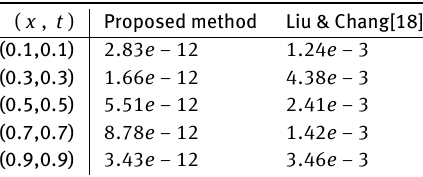
Table 5: A comparison of the proposed method and FE [5] to solve example 3.